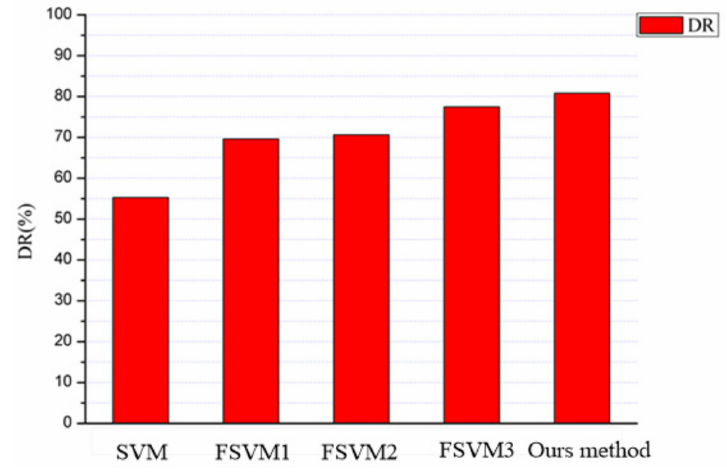
Figure 8. Performance comparisons on UNM_sendmail data